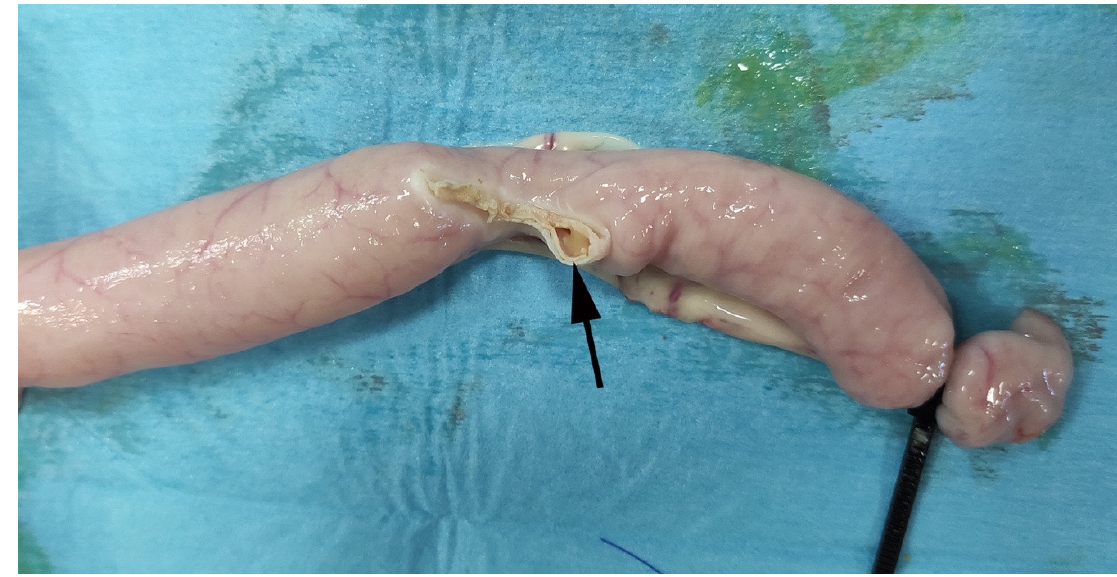
Figure 9. Representative image of RFVS-3 construct during BP test in study arm 2. The black arrow shows the failure site at maximum pressure.